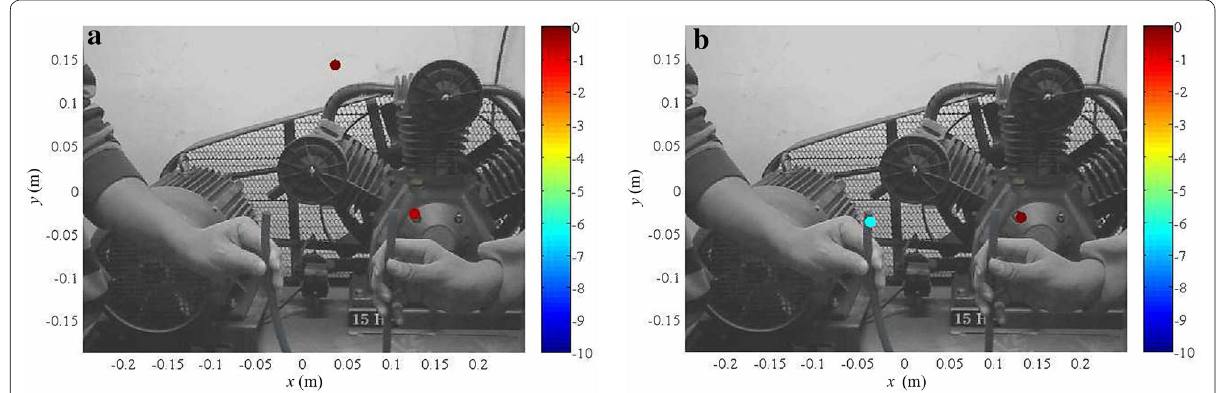
Figure 15 Source maps for the gas leakage experiment are obtained by: a DCS-SOMP method, and b DCS-SOMP-SVD method when the frequency range equals 11000 ‒ 11500